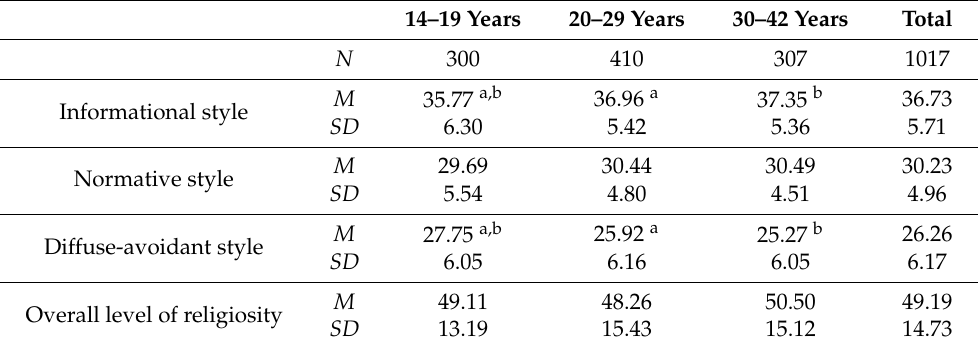
Table 2. Descriptive statistics for Identity Styles and